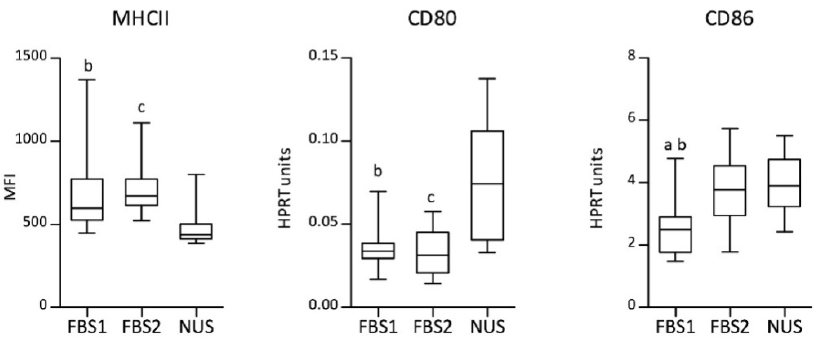
Figure 3. Surface markers CD14, CD16, CD163, and MHCII were assessed by flow cytometry and presented as the median fluorescence intensity (MFI). Relative expressions of CD80 and CD86 measured by qPCR are presented as HPRT units. Boxplots represent data from the MDM culture with fetal bovine serum (FBS1 and FBS2) or with reduced-serum medium (NUS): median (line), first and third quartiles (box), and minimum and maximum (whiskers); flow cytometry: n = 18, qPCR: n = 12. Significant differences (Friedman test with Dunn’s multiple-comparison post hoc test) between groups are marked as follows: a FBS1 vs. FBS2, p < 0.05; b FBS1 vs. NUS, p < 0.05; c FBS2 vs. NUS, p < 0.05.